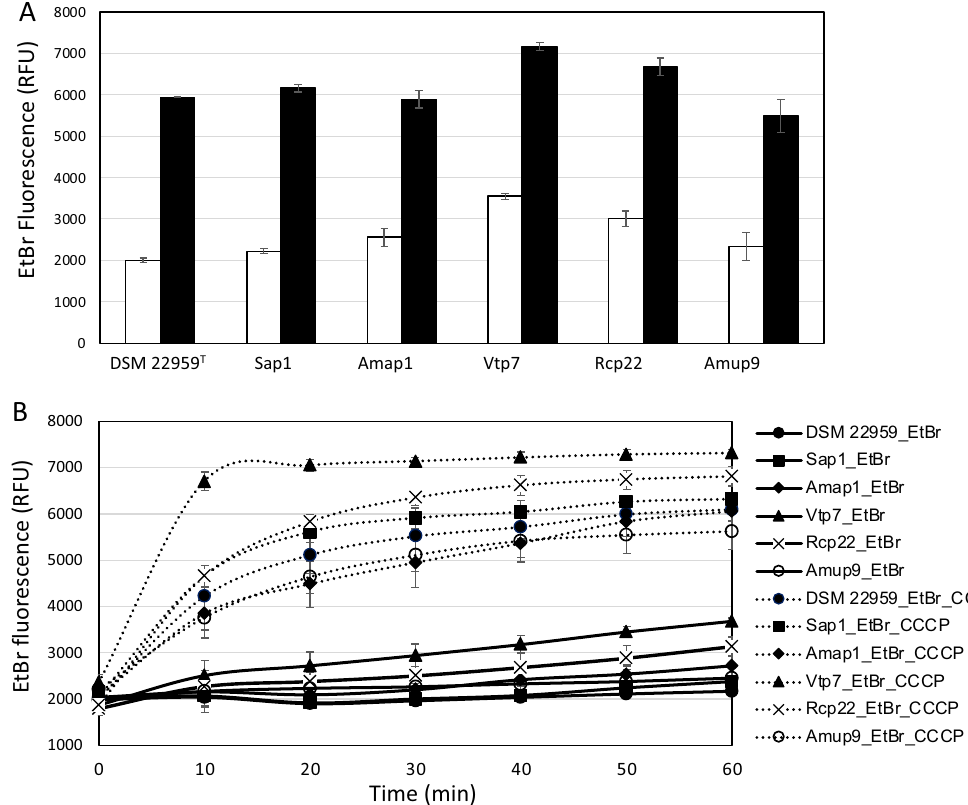
Figure 3. ( A ) Accumulation of ethidium bromide in A. muciniphila strains in absence (white bars) and in presence (black bars) of CCCP after 60 min of incubation. ( B ) Kinetics of ethidium bromide accumulation by A. muciniphila strains in absence (solid lines) and in presence (dashed lines) of CCCP. Data are shown as the average values of three replicates, with standard deviation. RFU, Relative Fluorescence